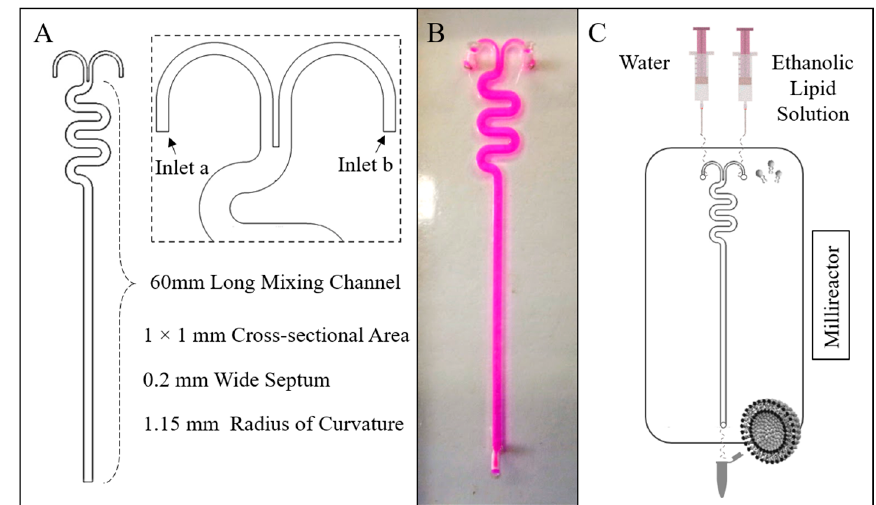
Figure 1. ( A ) The millireactor’s geometrical characteristics, ( B ) a top view photograph of the millireactor, and ( C ) a schematic illustration of the experimental approach for liposome production using the millireactor.